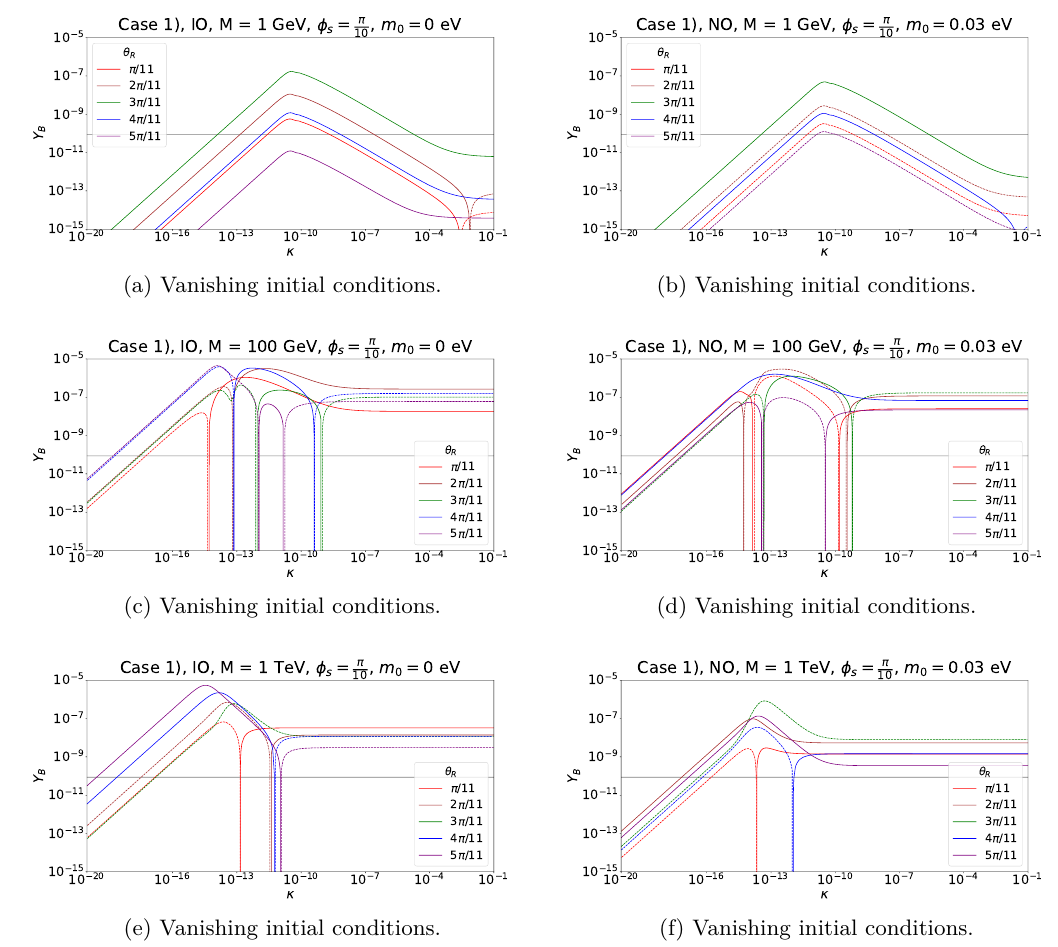
Figure 27 . Case 1) Y B as function of κ for a Majorana mass M = 1 GeV, M = 100 GeV and M = 1 TeV for light neutrino masses following strong IO (left plots) and NO with m 0 = 0 . 03 eV (right plots). The value of s is fixed to s = 1 and thus φ angle θ are displayed. Both negative (dashed lines) as well as positive (continuous lines) values of R the BAU are represented. The grey line indicates the observed value of the BAU, Y